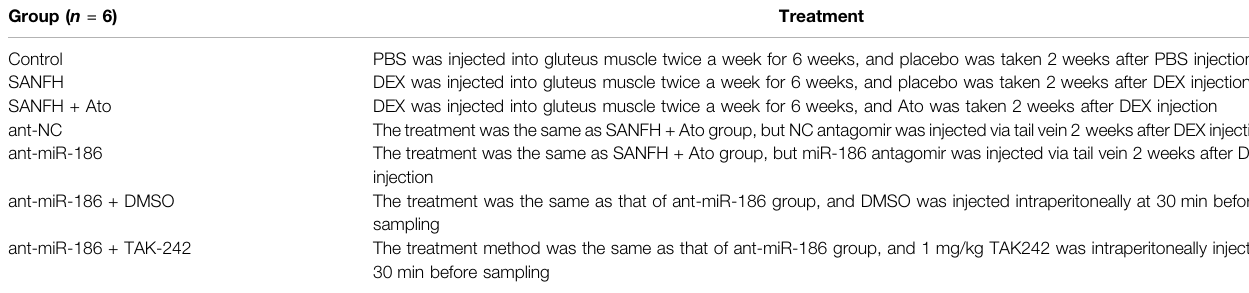
TABLE 1 | Details of rat grouping